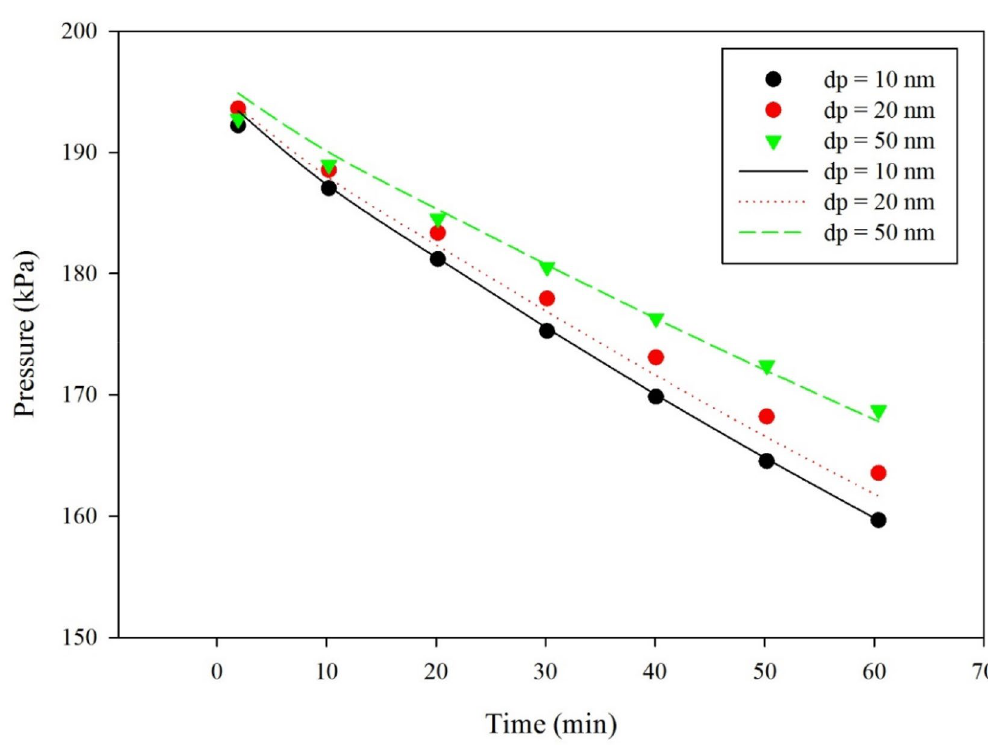
Figure 8. Comparison between model predictions (solid lines) and experimental data 20 for the change of CO 2 pressure with time at different TiO 2 particle size, with 0.1 wt% solid loading and a temperature of 25 °C, 0